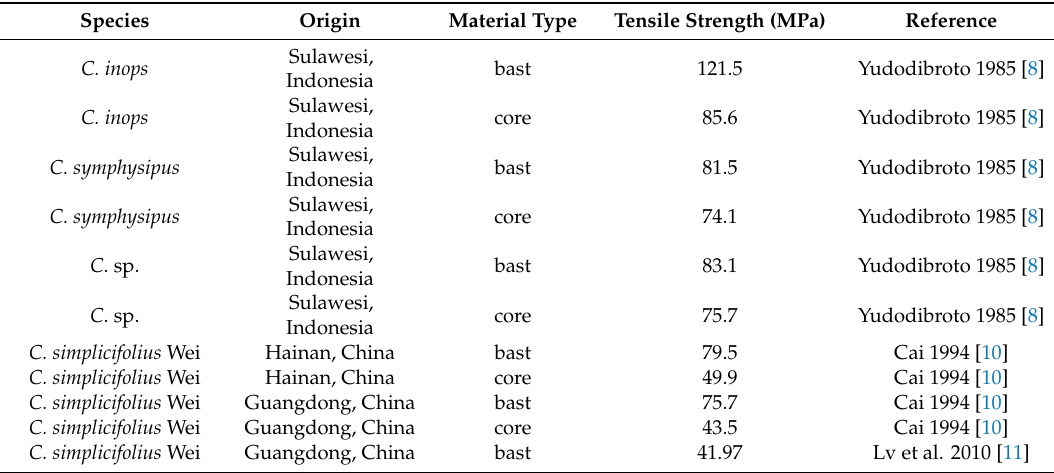
Table 1. Summary of reviewed tensile properties of natural rattan